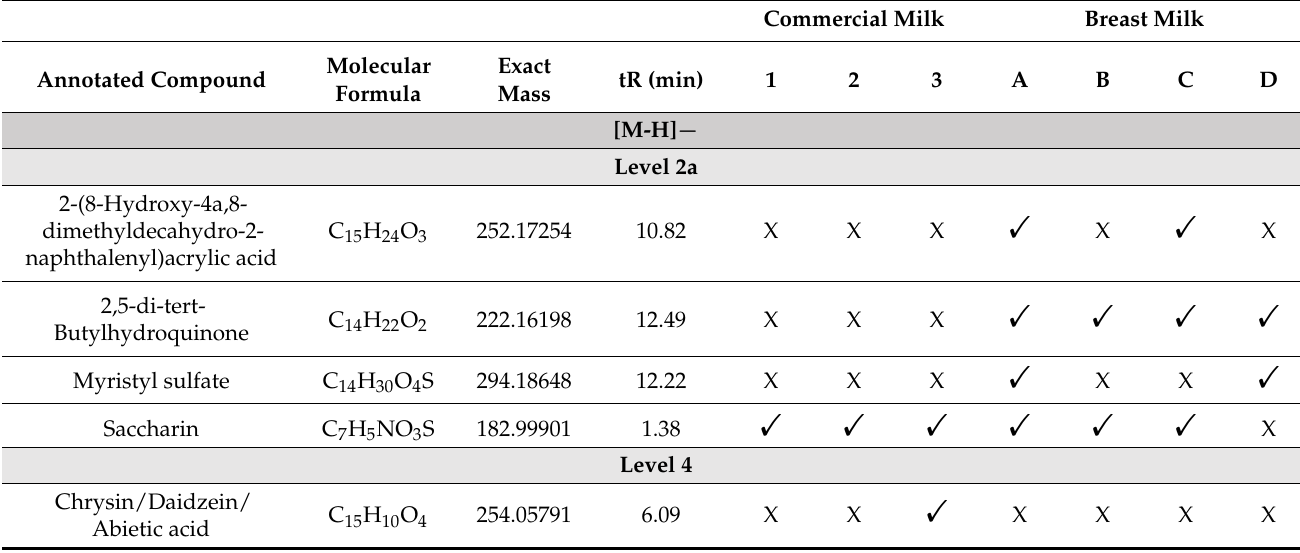
Table 6. Cont. Commercial Milk Breast